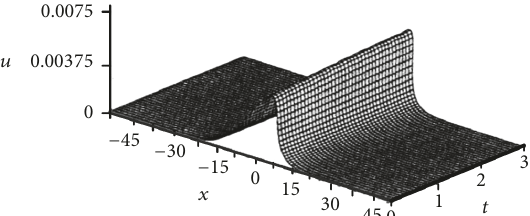
Figure 5: The shape of approximated solution 𝑢 app = 𝑢 3 in the conventional case ( 𝛾 = 1 ). It is plotted with respect to different fixed values of time and space at 𝑘 = 2.5 , 𝑑 = 4.0 , 𝜁 = 0.01. The motion is quite standard and regular.